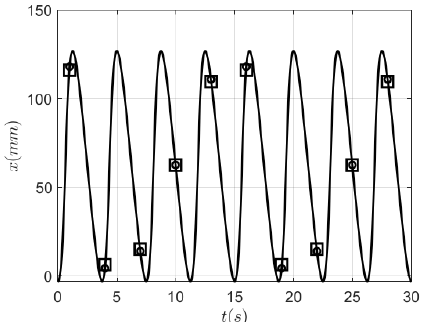
Figure 5. Piston displacement - analytical results (circle markers) and numerical results (square markers) - case study 1